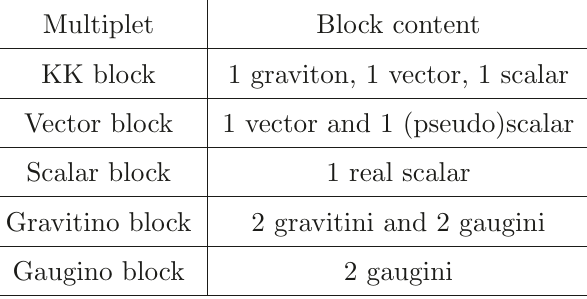
Table 1 . Decomposition of quadratic